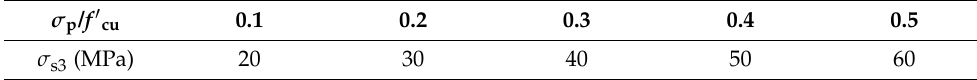
Table 3. Prestress loss caused by concrete shrinkage and